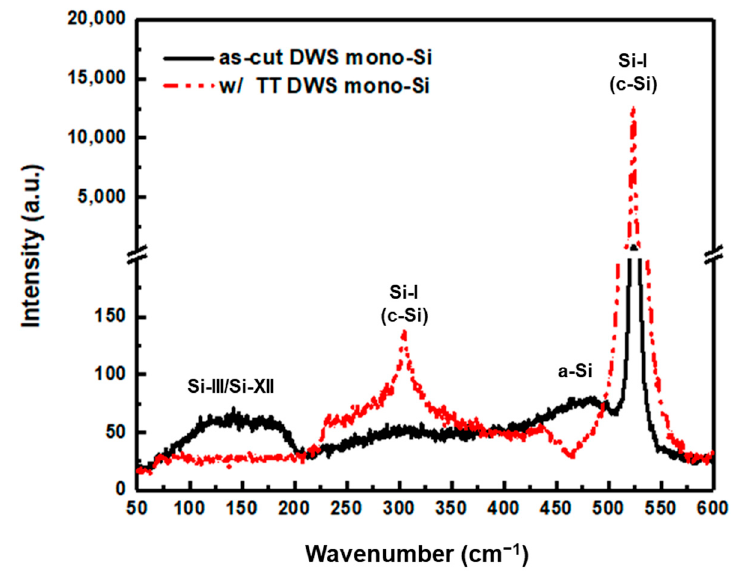
Figure 1. Raman spectra before and after thermal treatment (TT) of as-cut monocrystalline Si (mono-Si) wafer manufactured via diamond wire sawing (DWS) method.